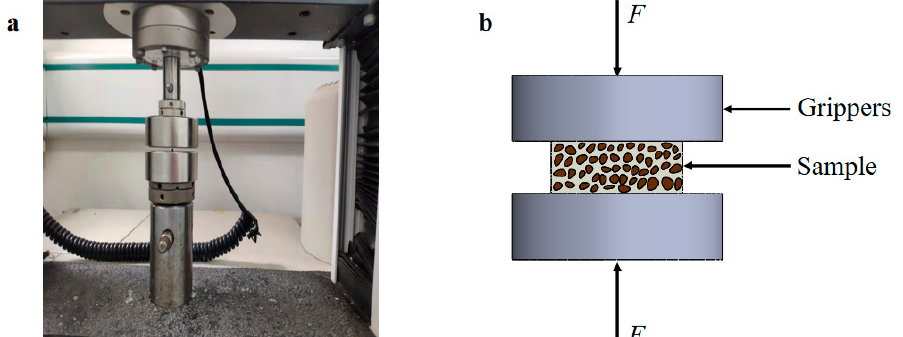
Figure 2. ( a ) Photo of compression fixture, ( b ) Schematic diagram of sample